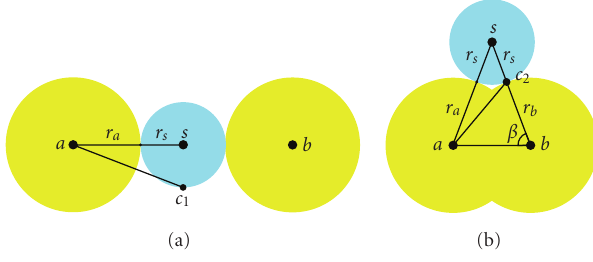
Figure 2: Two situations in which the Gaussian functions would have contradictory properties. (a) Two atoms of the molecule, a and b , are just close enough to block the way to a solvent molecule s . The point c 1 is on the SES and must be influenced by the filed generated by a , G a . (b) a and b are close. The point c 2 is on the SES but also on the VdWS. So, it should not be influenced by G a . It is possible to show that in some (frequent) configurations, (cid:2) ac 1 (cid:2) > (cid:2) ac 2 (cid:2) .